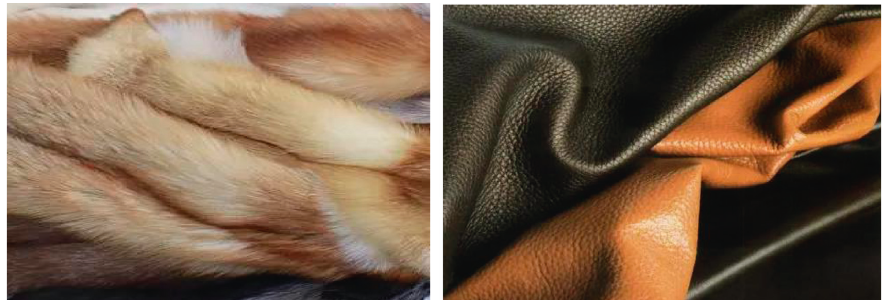
Figure 1: Legend of fur and leather. Table 1: Classification of fur and